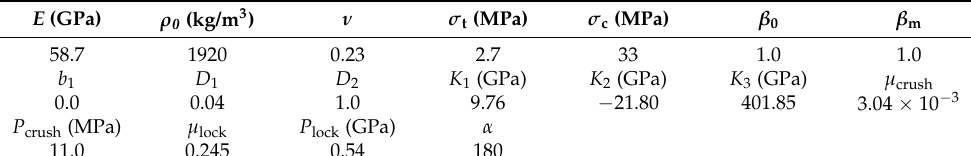
Figure 16. Stress-strain relationship of deep-metamorphic limestone under different confined pressure. Table 3. The parameters of tuff.